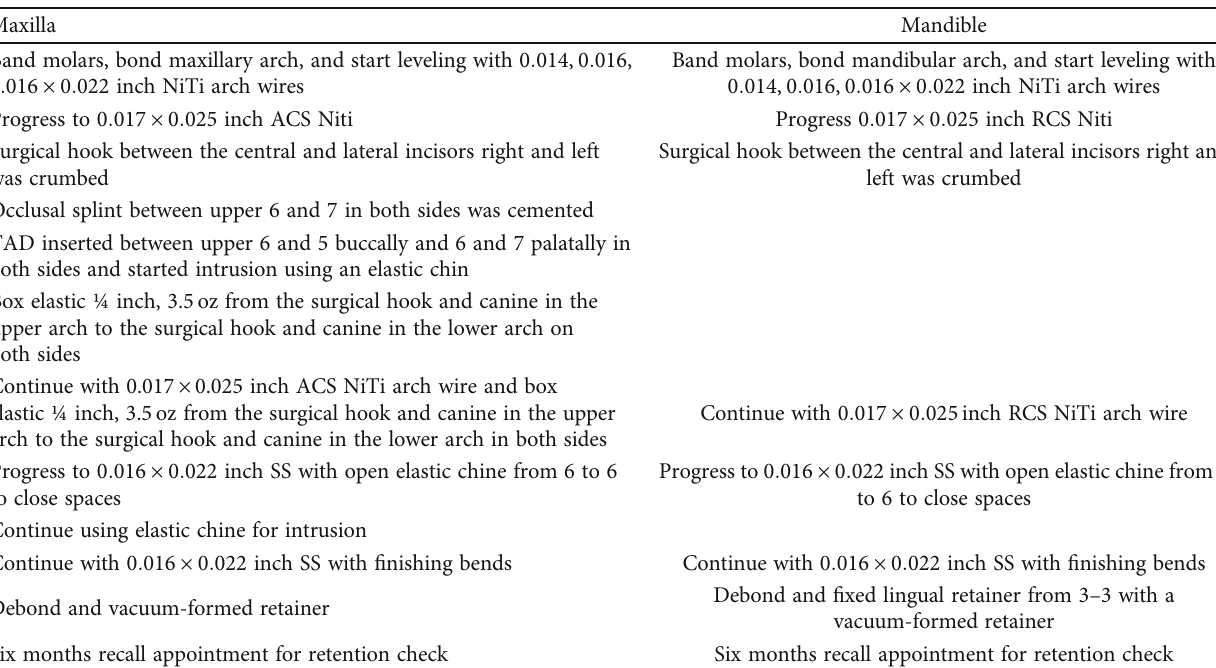
Table 1: Treatment sequence and biomechanical plan.